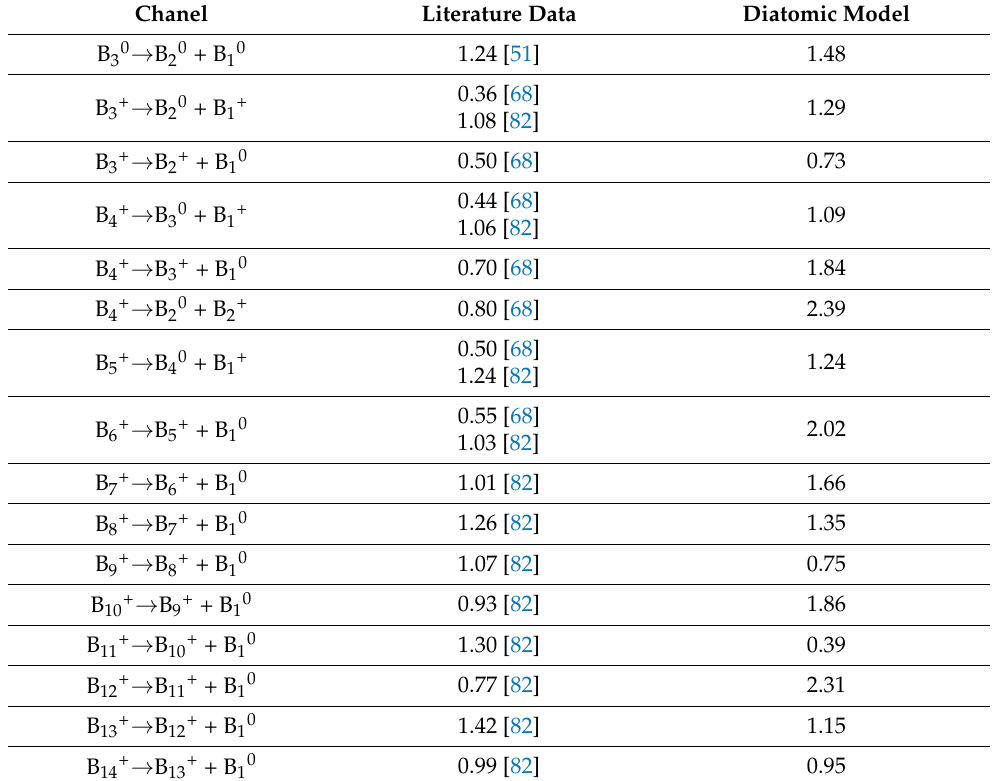
Table 3. Comparison of the literature data on specific fragmentation energies (in eV) of boron small clusters with values calculated in diatomic